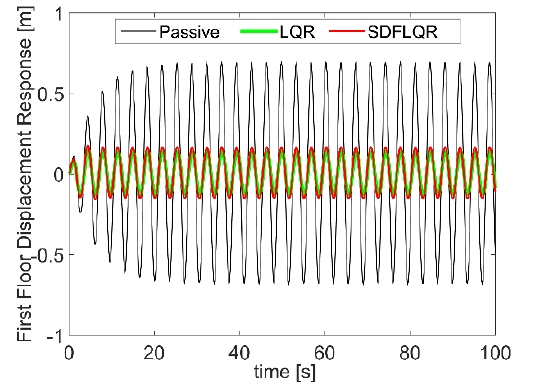
Figure 2. Controlled and uncontrolled displacemet time responses of first floor of offshore steel jacket platform.